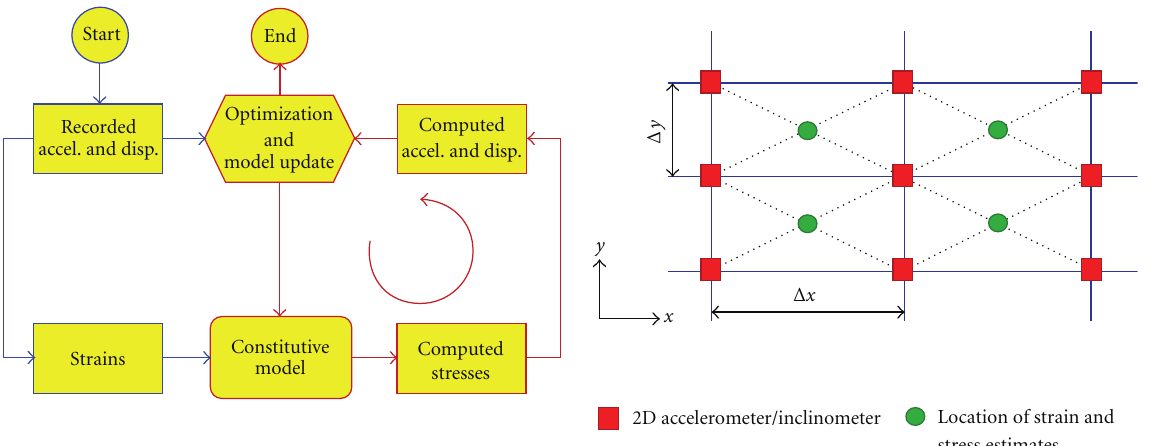
Figure 15: Algorithm of the developed local system identification technique and detail of instrument configuration for a 2D local iden- tification analysis.